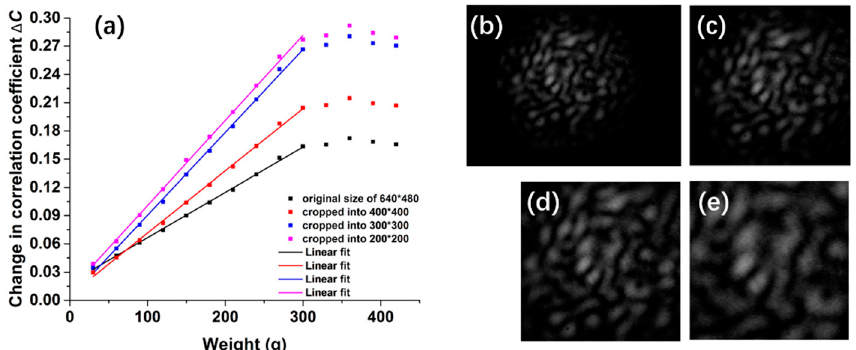
Figure 7. ( a ) Pressure response of different sizes of patterns; ( b ) Original pattern recorded directly by CCD; ( c ) Pattern cropped into 400 × 400; ( d ) Pattern cropped into 300 × 300; ( e ) Pattern cropped into 200 × 200.